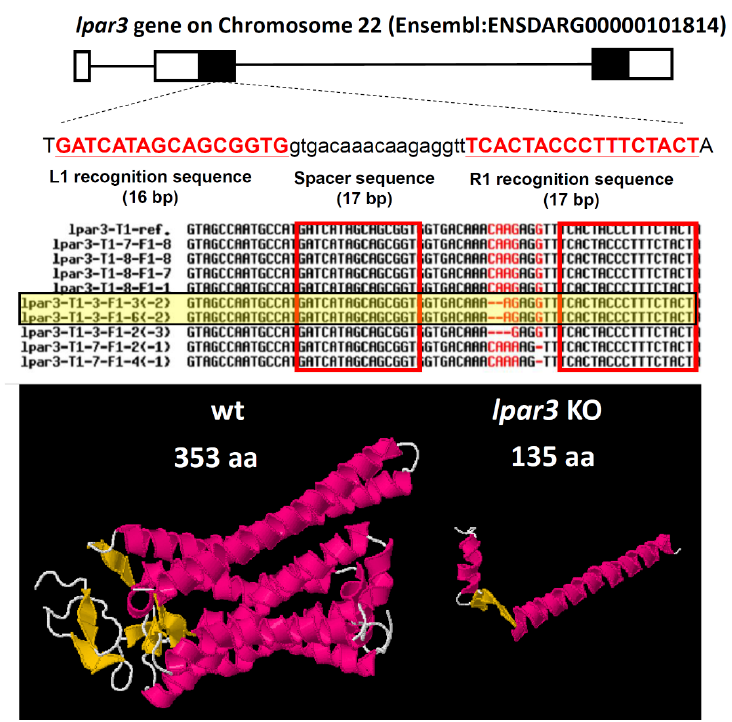
Figure A1. Generation of lysophosphatidic acid receptor 3 ( lpar3 ) gene knockout zebrafish by using the transcription activator-like effector nuclease (TALEN) genome editing tool. Scheme shows the TALEN left and right arm sequences used to target the lpar3 gene on exon 2 in zebrafish (top panel). The left and right arm (highlighted by red color) and spacer sequences used for the TALEN design are also listed. Comparison of the Sanger sequencing results of the F1 generation that carried potential mutations for the lpar3 gene. The stable lpar3 KO fish used in this study carrying a 2 nucleotide-deletion (delCA) results in the predicted, truncated LPA3 protein. The predicted three-dimensional structure of the LPAR3 protein for wild-type (wt, containing 353 amino acids) and lpar3 KO fish (with 135 amino acids). The beta sheet, alpha helix, and random coil protein domain structures are highlighted with yellow, pink, and white colors, respectively. Table A1. Summary of zebrafish behavior endpoints measured from the novel tank, mirror biting, predator avoidance, social interaction, and shoaling tests.